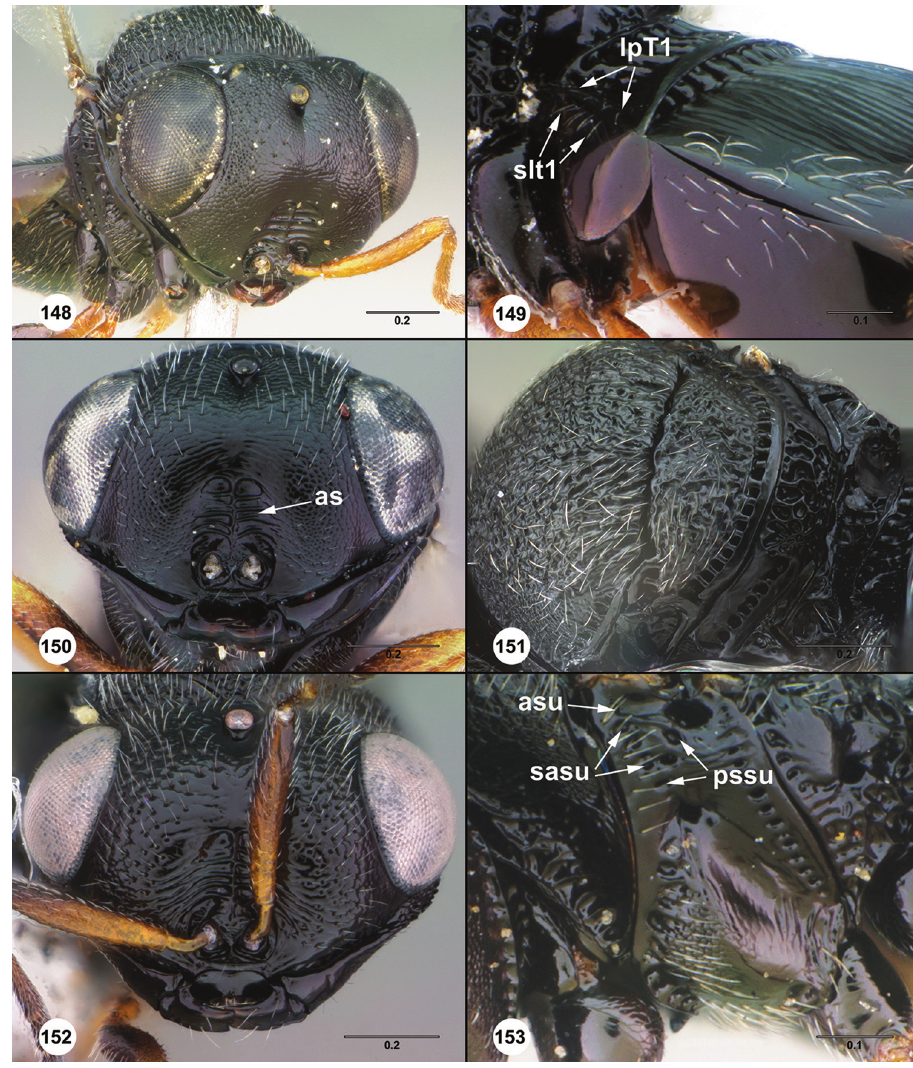
view. Scale bars in